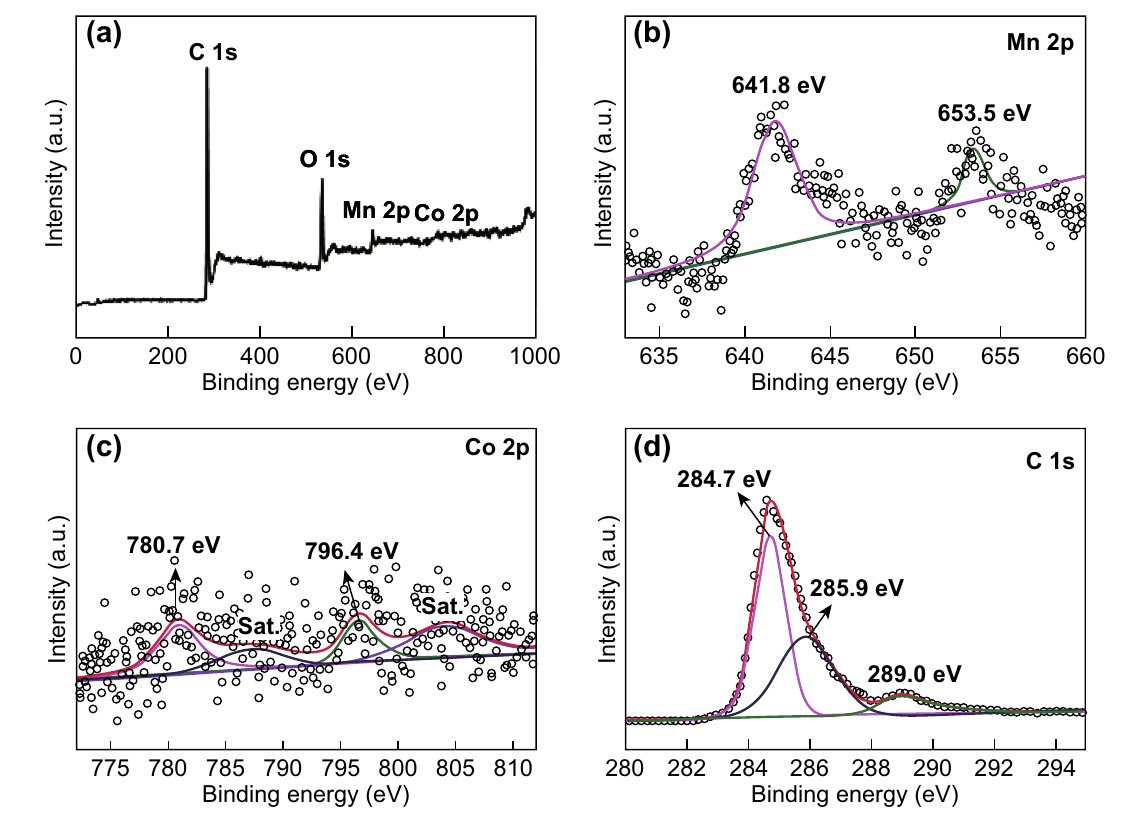
Fig. 4 XPS spectra for the MnO/CoMn 2 O 4 ⊂ GN composites: a the survey spectrum and the high-resolution spectra for b Mn 2p, c Co 2p and d C